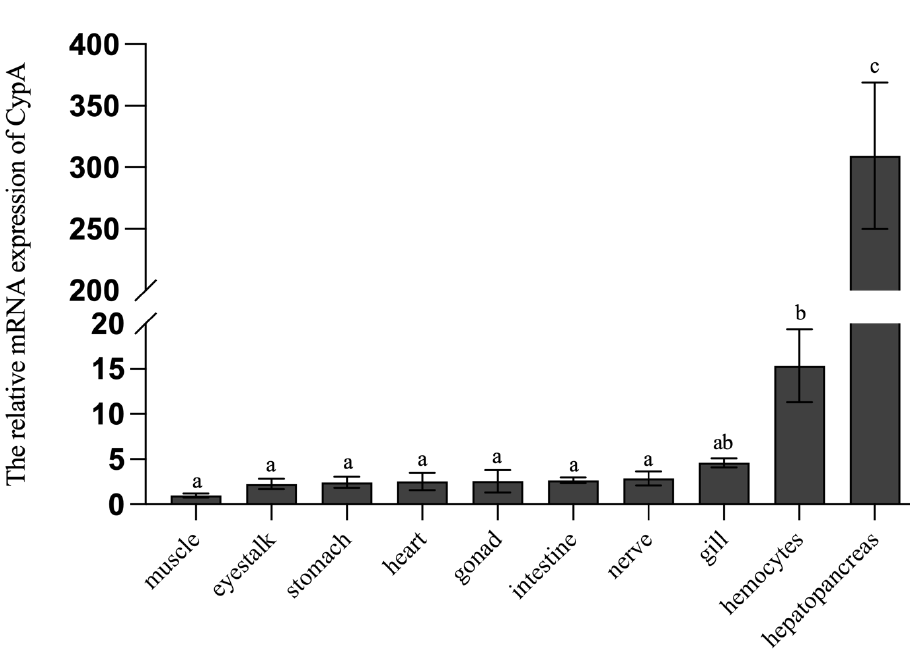
Fig. 4 Relative expression of Fc CypA gene in ten tissues. The mRNA transcripts levels in muscle, eyestalk, stomach, heart, gonad, intestine, nerve, gill, hemocytes and hepatopancreas of three untreated shrimps were normalized to that of muscle. The 18S rDNA gene was used as an internal control to calibrate the cDNA template for each sample. Each vertical bar represents the mean ± SD (n = 5), and Different letters indicate significant differences ( p <